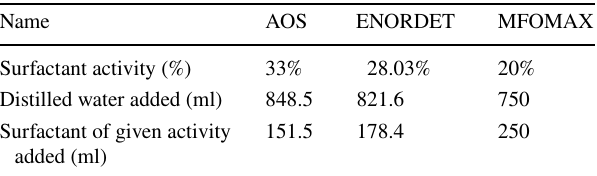
Fig. 2 The graduated cylinder used in bulk foam stability